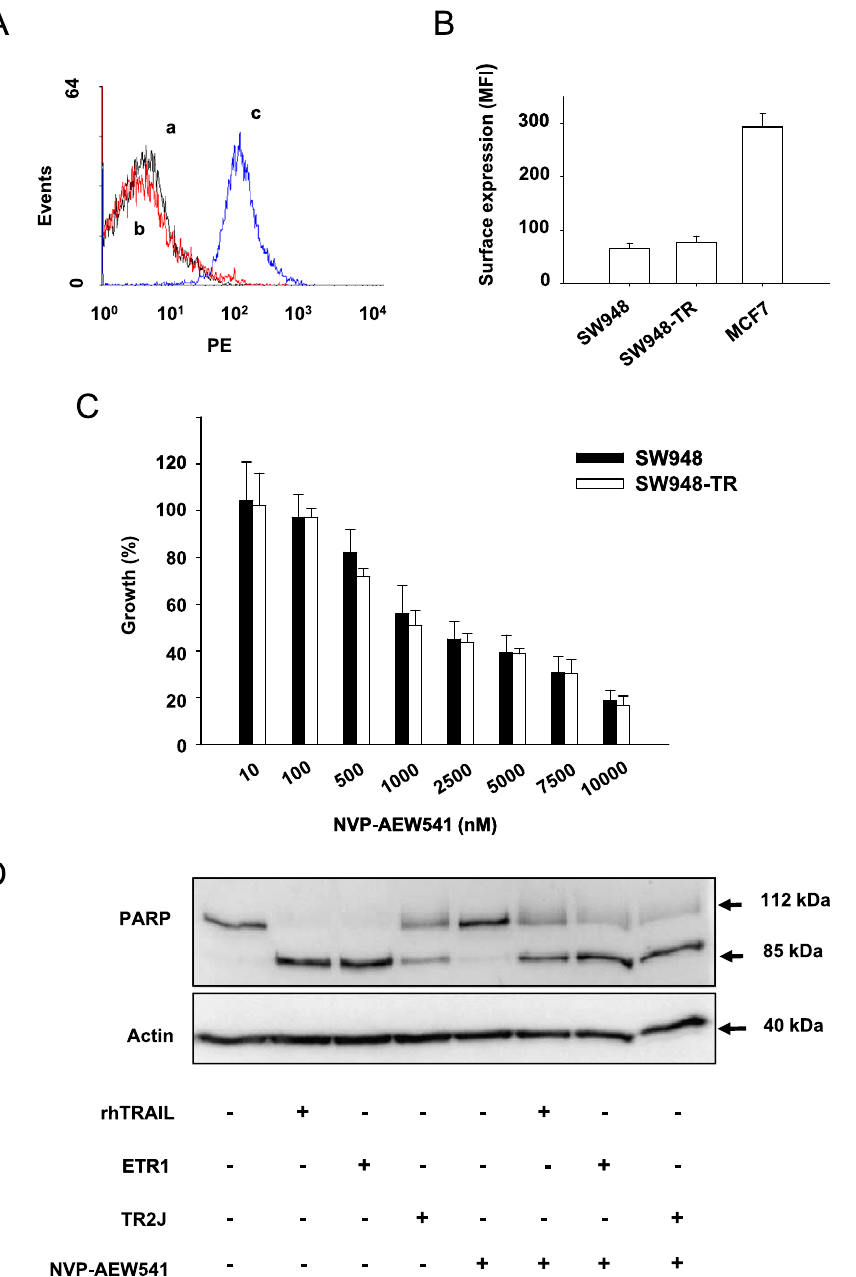
Fig. 1. SW948 and SW948-TR cells express surface IGF-1R and inhibition of this receptor modifies sensitivity to death receptor agonists. (A) Representative example of IGF-1R expression in SW948. Positive receptor expression was detected as an increased fluorescence intensity of the whole cell population and resulted in a peak-shift to the right (a – control; b – IgG1 and c – IGF-1R). (B) Surface expression of IGF-1R in SW948, SW948-TR and MCF7 cells (positive control for IGF-1R expression), as determined by flow cytometry. IGF-1R expression is given as Mean Fluorescent Intensity (MFI), normalized to 100. Values are mean ± SE of at least three independent experiments. (C) Survival (%) of SW948 and SW948-TR cells after continuous incubation with NVP-AEW541 for 96 h, as measured by cytotoxicity assays. Values are mean ± SD of at least three independent experiments. (D) Western blot analysis of PARP cleavage in SW948. The cells were pre-incubated for 15–18 h with 5 µM NVP-AEW541, then either left untreated or exposed for 3 additional hours with rhTRAIL (0.1 µg/ml), HGS-ETR1 (50 nM) or HGS-TR2J (50 nM) before harvest. (Colors are visible in the online version of the article;